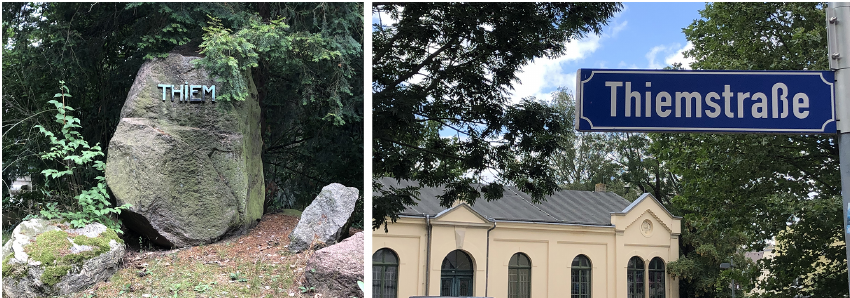
Figure 2. The left panel shows the grave of honour of the Thiem family at the Südfriedhof in Leipzig. The gravestone is an erratic block found during the construction of the neighbouring monument (Völkerschlachtdenkmal) commemorating the decisive Battle of Leipzig against Napoleon in 1813. The right panel is a road sign of Thiemstraße (Straße means street) in Leipzig (photos: Georg